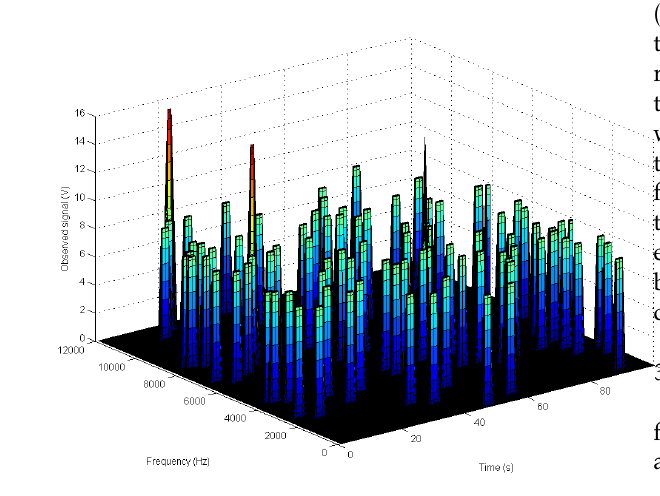
Figure 1. Example of temporal & spectral repartitions of